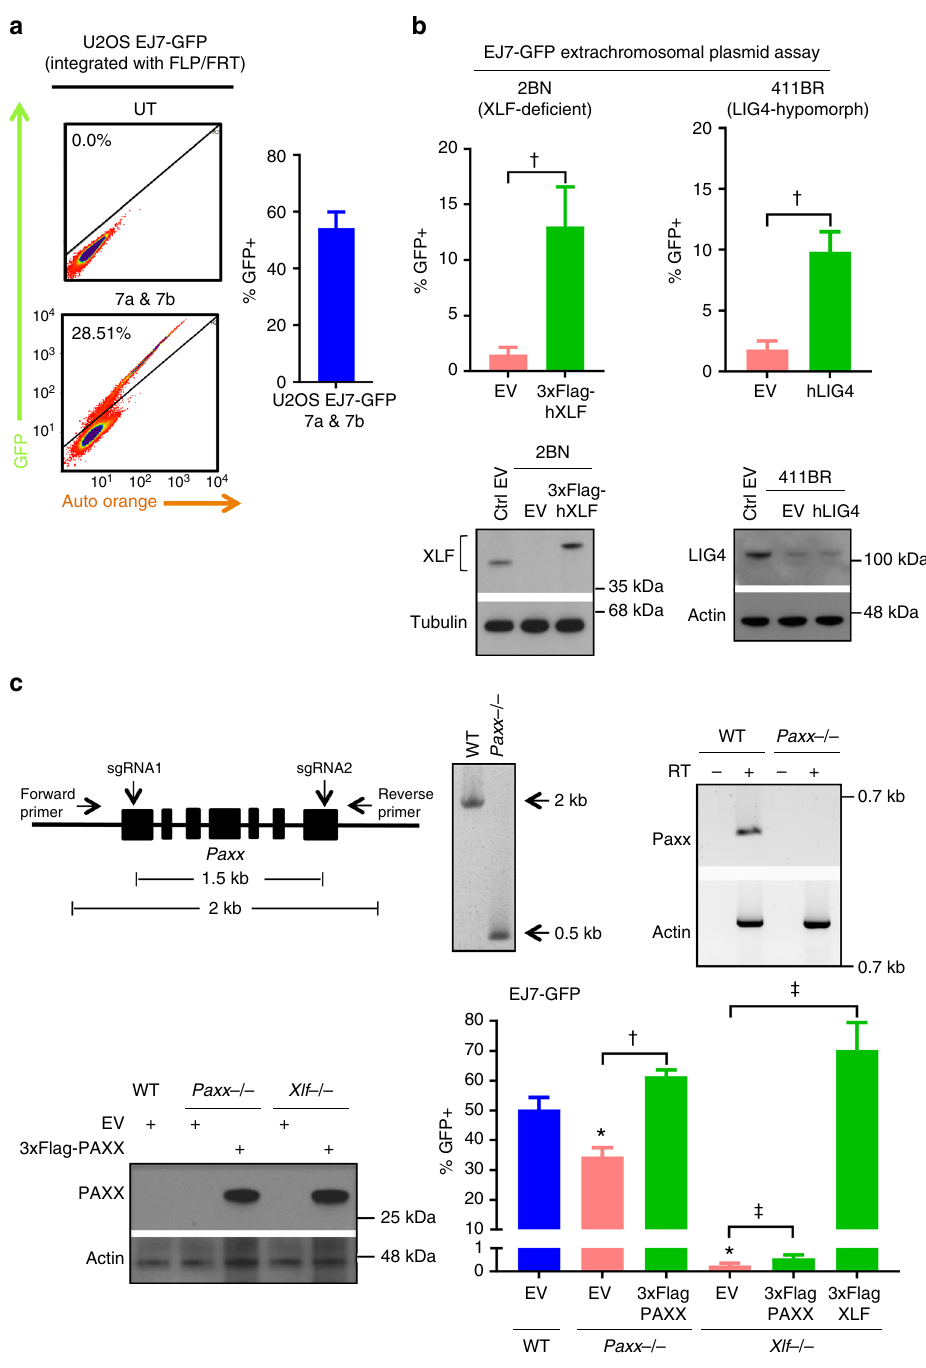
Fig. 2 Distal EJ without indels is mediated by C-NHEJ in human cells; PAXX has a modest role on such EJ. a EJ7-GFP in U2OS. Shown are representative fl ow cytometry plots, and the frequency of GFP + cells normalized to transfection ef fi ciency, for the EJ7-GFP reporter integrated into U2OS cells, which were transfected with expression vectors for Cas9 and the 7a and 7b sgRNAs. N = 5, and error bar indicates s.d. b EJ7-GFP extrachromosomal plasmid assay in human fi broblasts. XLF-de fi cient (2BN) and LIG4 hypomorph (411BR) cells were transfected with EJ7-GFP, along with expression vectors for Cas9 and the 7a and 7b sgRNAs. Also included was a control (EV) or human (h) complementing vectors: 3xFlag-hXLF or hLIG4. Shown is the frequency of GFP + cells normalized to transfection ef fi ciency. N = 6, error bars indicate s.d. † p < 0.0001, EV vs. complemented using an unpaired, two-tailed t -test. Shown are immunoblots for XLF and LIG4. The relative migration of 3xFlag-hXLF vs. endogenous XLF is consistent with the difference in molecular weight. c PAXX has a modest in fl uence on EJ7-GFP. Shown is a diagram for Paxx gene disruption, with PCR and RT-PCR analysis for loss of the Paxx gene and transcript, respectively. Shown is the frequency of GFP + cells normalized to transfection ef fi ciency, for WT, Paxx − / − ¸ and Xlf − / − mESCs with EJ7-GFP, and transfected with expression vectors for Cas9 and the 7a and 7b sgRNAs, with either EV or complementation vector. N = 6, error bars indicate s.d. Shown are immunoblots for PAXX expression. * p < 0.0001, WT vs. mutants; ‡ p ≤ 0.0008, EV vs. complemented, both using an unpaired t -test with the Holm- Sidak correction. † p < 0.0001, EV vs. complemented using an unpaired, two-tailed t